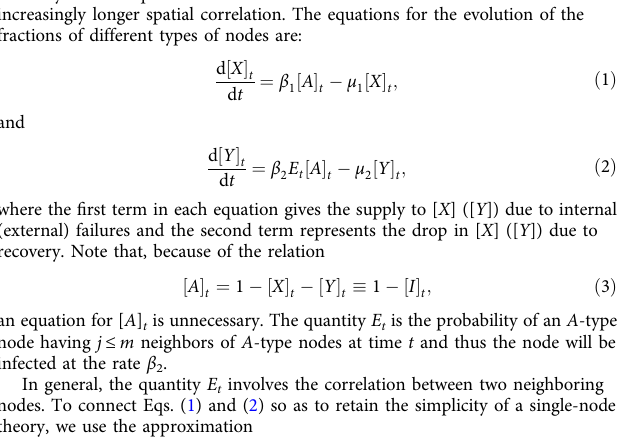
Fig. 7 MR and NMR dynamics on heterogeneous networks. The networks are scale-free with N = 30,000 nodes, degree exponent γ = 3, k min = 6 and k = 173. Shown is the dependence of β max c for reaching a high-failure state on the initial value of [ X ] 0 , with [ Y ] 0 = 0, in the MR and NMR models for β = 1.9, μ = 0.01, μ = 1, τ = 100, and τ = 1. The results qualitatively 2 1 2 1 2 consistent with those in Fig. 4c for MR dynamics and in Fig. 5c for NMR dynamics on random regular networks.